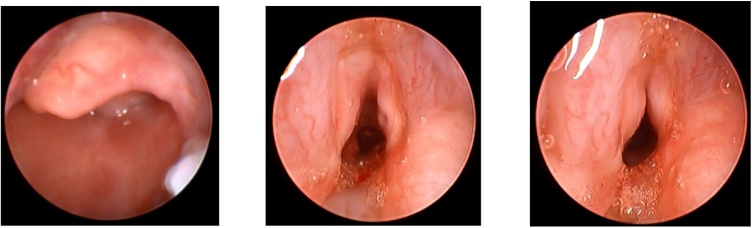
Images - Direct Microlaryngoscopy Showing Grade III Subglottic Stenosis.